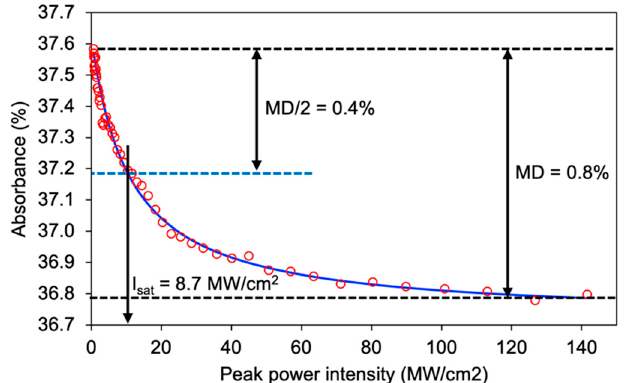
Figure 5. Nonlinear saturable absorbance properties of GNP-SA.